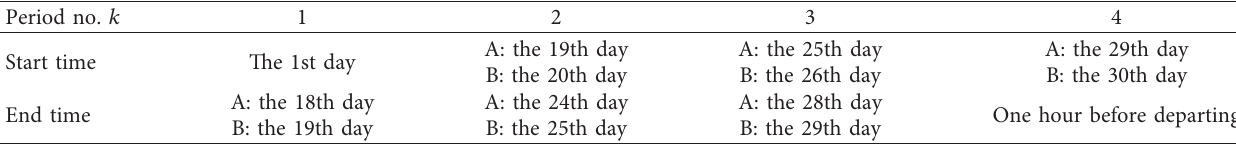
Table 4: Booking horizon division of numerical